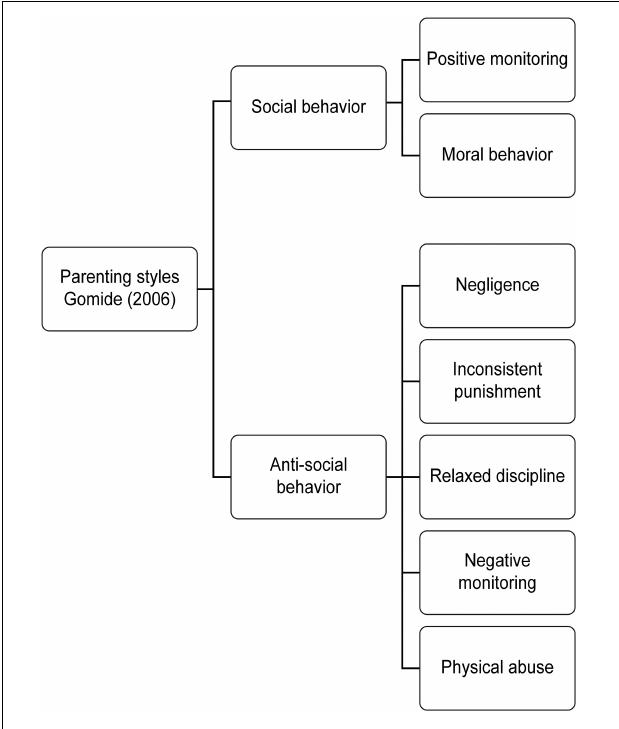
FIGURE 2 | Parental styles (Gomide, 2006).